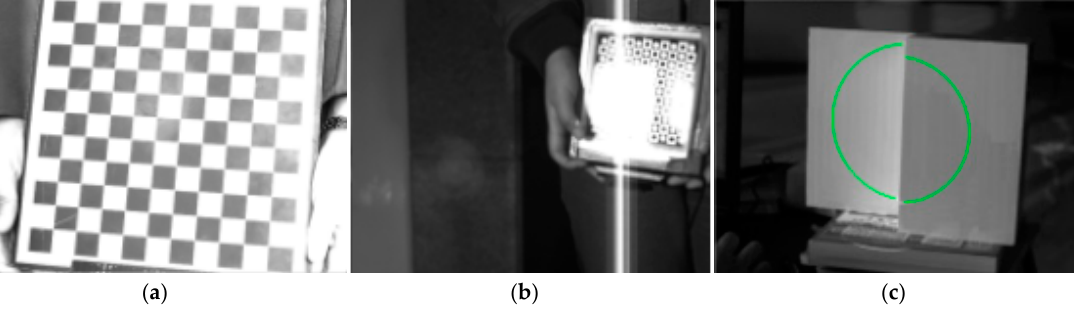
Figure 10. Calibration images based on two methods in the strong sunlight environment. ( a ) Calibration